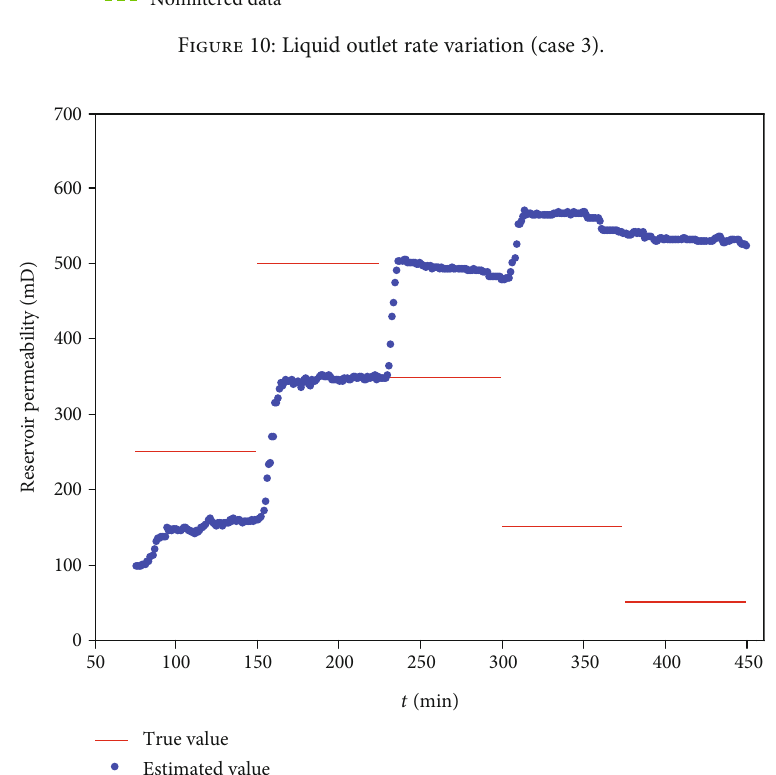
Figure 10: Liquid outlet rate variation (case 3).